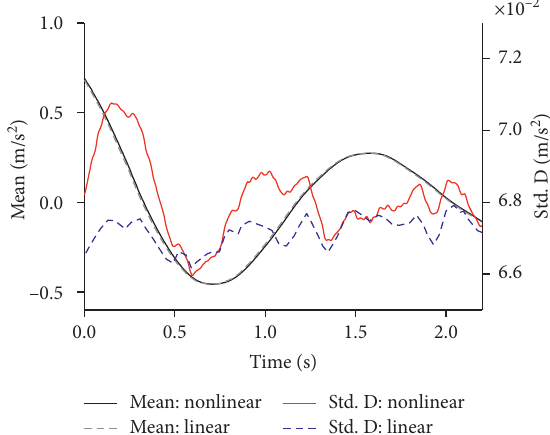
Figure 5: Comparison of wheel-rail contact force of first wheelset (double side).